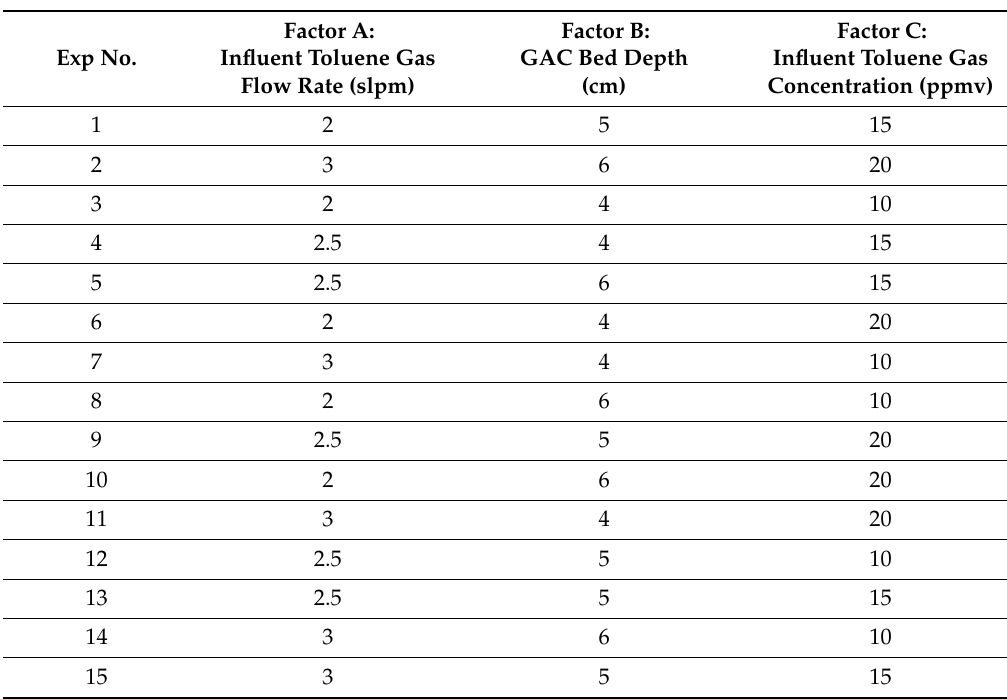
Table 2. Design Table for toluene Adsorption RSM Modeling.